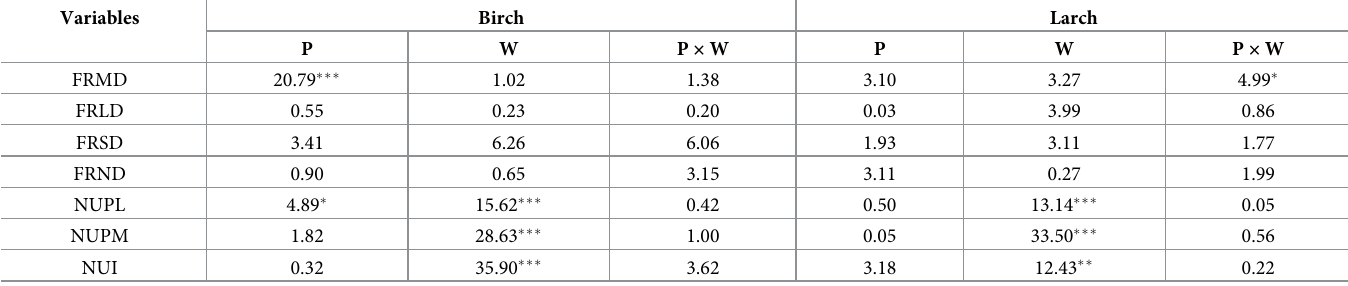
Table 3. F values from analysis of variance (ANOVA) of nutrient distribution pattern (P), water condition (W), and their interaction (P × W) on variables assessing root foraging plasticity and nutrient utilization in birch ( Betula Platyphylla ) and larch ( Larix olgensis ) seedlings. Variables Birch